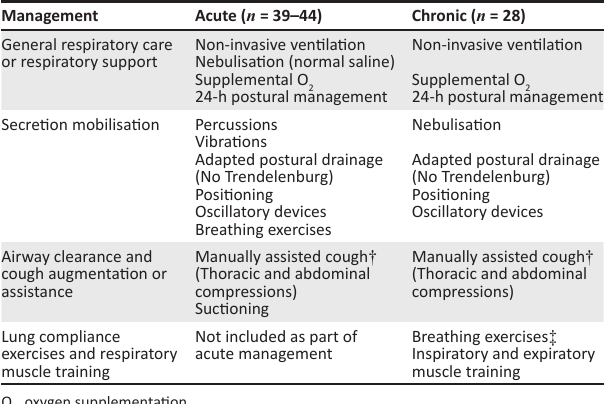
TABLE 3: Summary of preferred techniques in acute and chronic management of children with neuromuscular diseases.